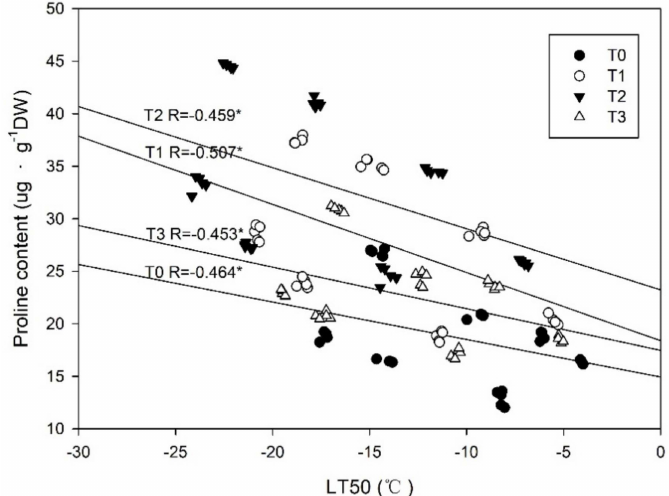
Figure 11. Correlation coe ffi cients between the freezing tolerance (estimated as LT50) and proline content in the shoots of Magnolia wufengensis under ETH treatments. Note: T0, T1, T2, and T3 indicate the application of 0, 700, 1000, and 1500 mg · L − 1 ETH, respectively. The regression line is T2, T1, T3, and T0 from the top to bottom. * indicate significance at p < 0.05,